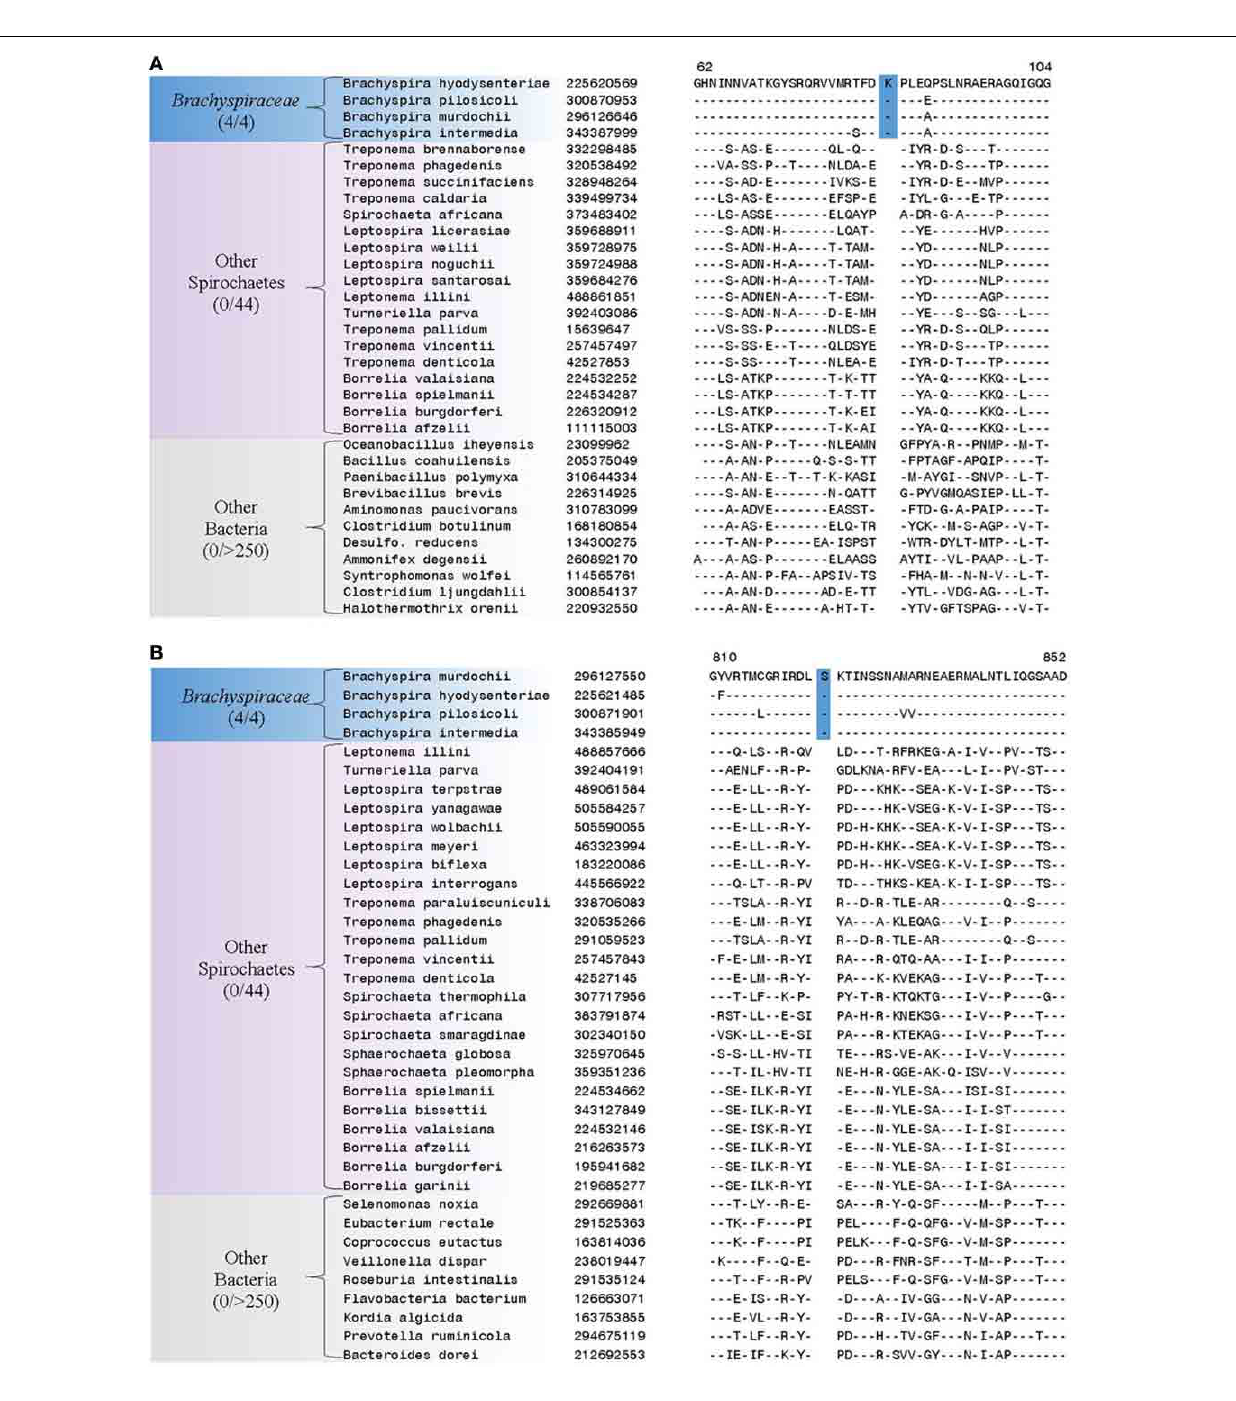
FIGURE 5 | Partial sequence alignments of (A) Flagellar hook-associated protein FlgK and (B) DNA polymerase I, showing two CSIs that are specific for the family Brachyspiraceae , but not found in the sequence homologs of any other sequenced bacteria. Sequence homologs for